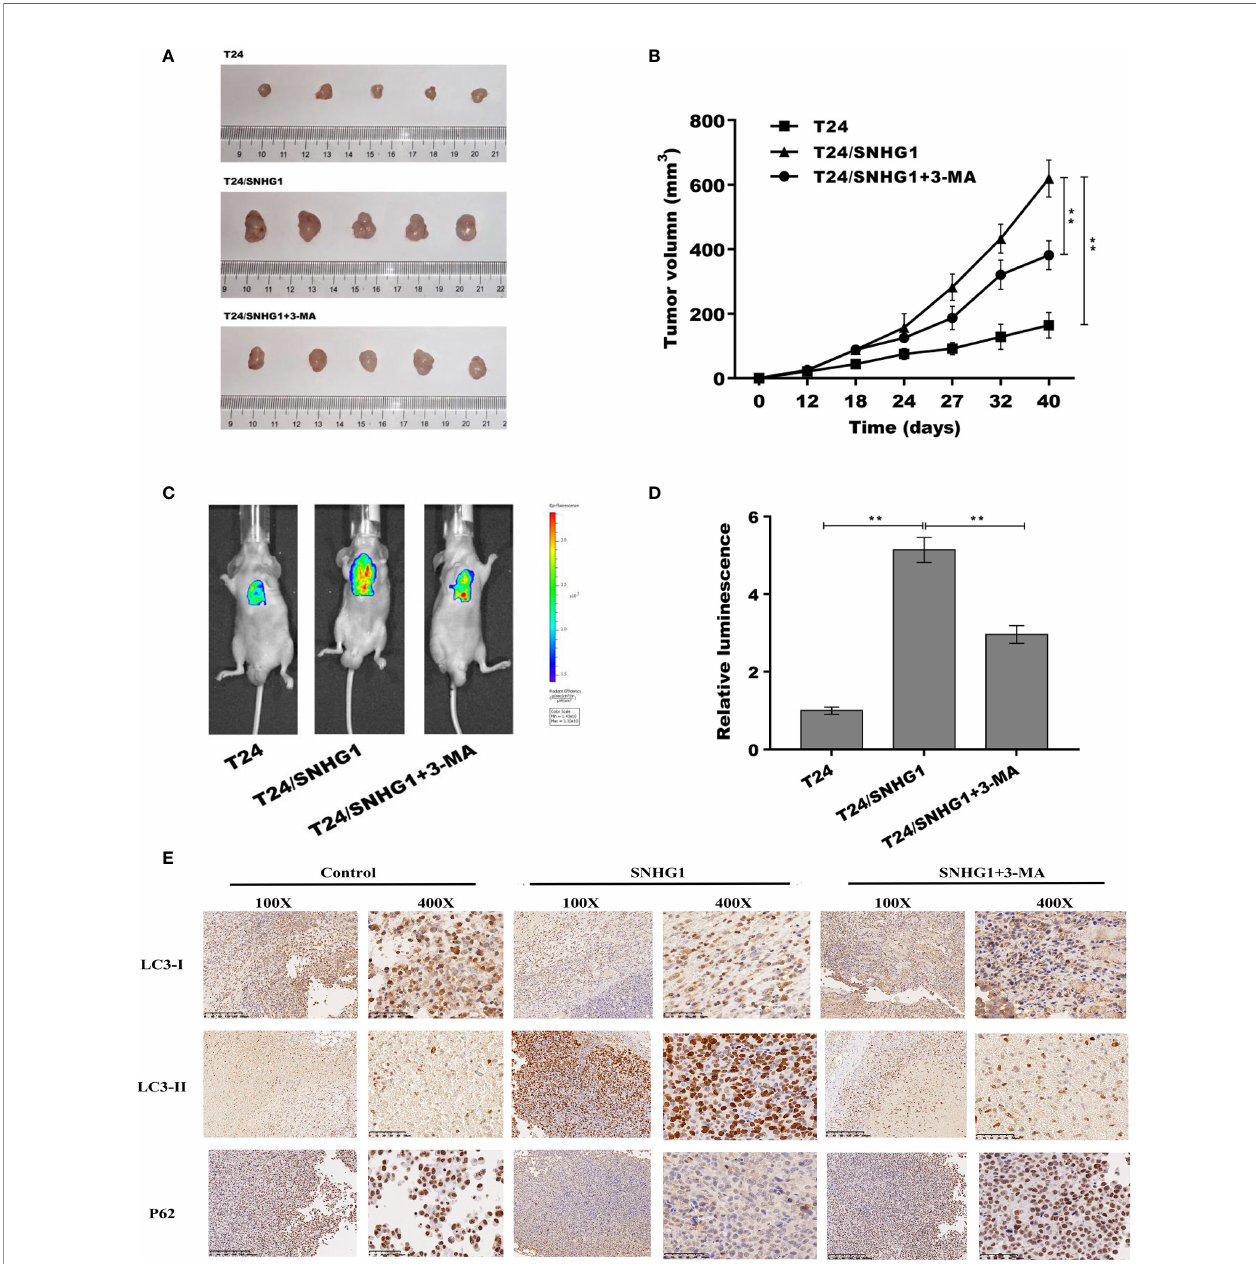
FIGURE 6 | T24 cells stably transfected with SHNG1 plasmid or vector were injected subcutaneously into nude mice to establish subcutaneous xenograft tumors (5 × 106 cells per mice, each group contains 8 mice). Tumor growth curve and weight decreased in the SNHG1 group compared with the vector group. Data are presented as mean ± SEM, **P < 0.01 versus vector group. (A) After sacri fi cing the mice, the tumor tissues were obtained. (B) The tumor volume was measured at different times; (C) IVIS imaging was used to determine the tumor size in different groups (D) The quantitative analysis of IVIS imaging in different groups (E) The IHC detection of LC3-I, LC3-II, and P62 in subcutaneous xenografts of the three groups. (Data presented as mean ± SD, **p<0.01 compared to the